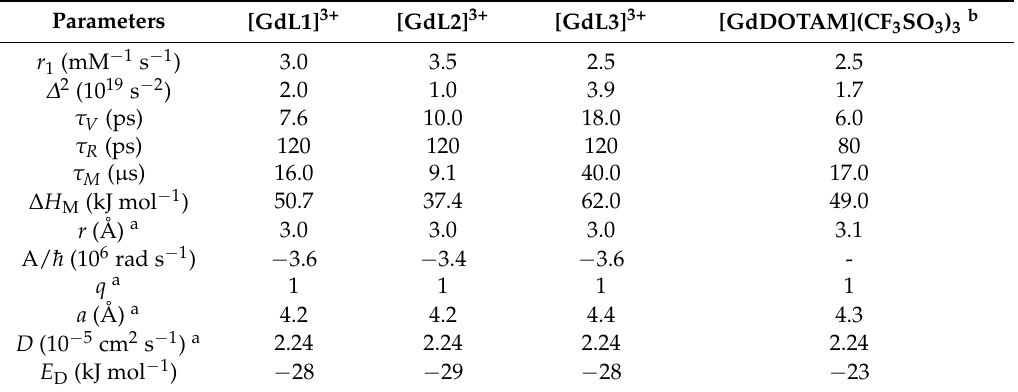
a Parameters fixed during the fitting procedure. b Taken from Reference [9].